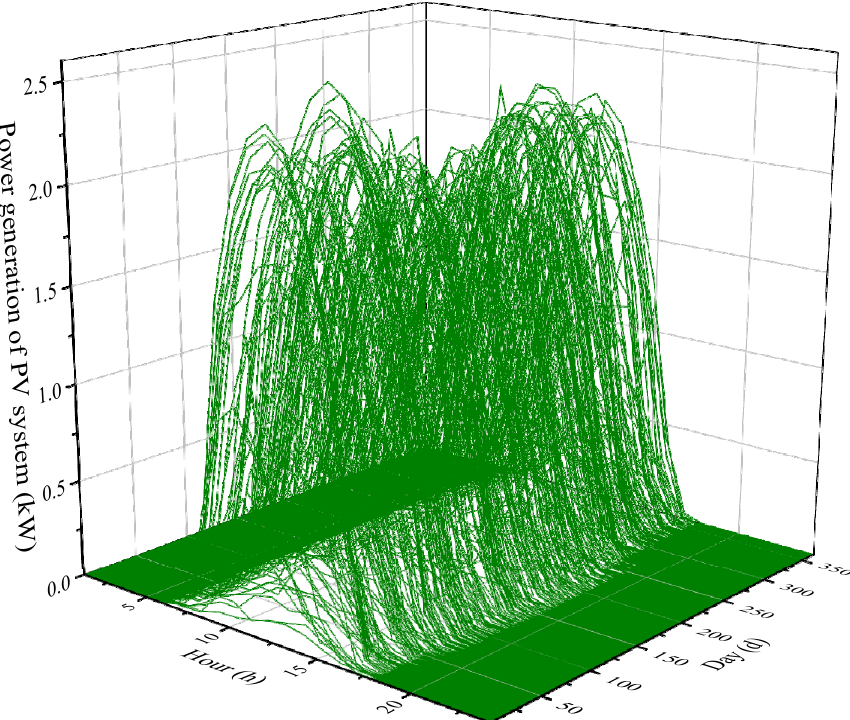
Figure 5. Hourly PV power distribution in 2018.